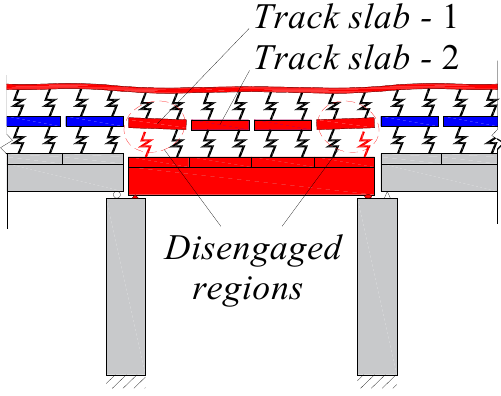
Figure 8. Schematic diagram of girder vertical fault.